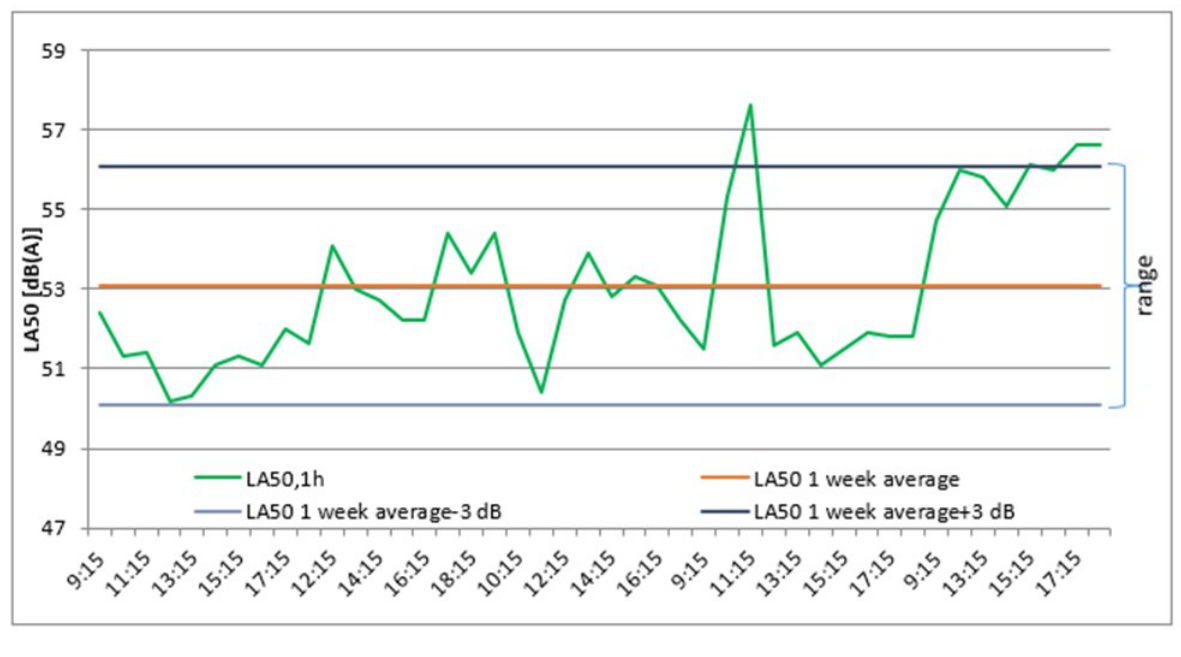
Figure 6: Long–term measurements collected in the Dionisi schoolyard during its opening times. Table 6: Time periods in which the LA50 falls in the defined range and average values of L50 and L10–L90 ( T = 1 week) at the Dionisi school. LA50 LA10–LA90 LA50 LA10–LA90